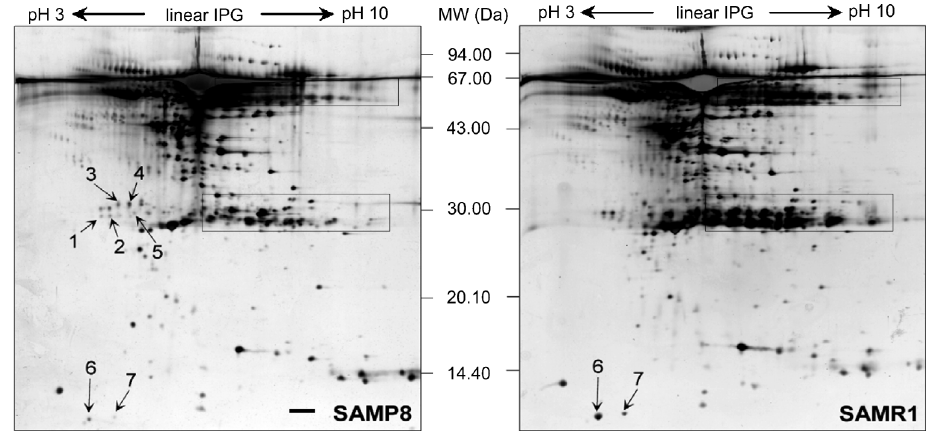
Figure 1. Representative 2-dimensional gels of serum proteins and differentially expressed protein spots. After determining the protein concentrationusing the Bradford assay, 150 m g serum proteinwas loaded on pH 3-10 linear IPG (Immobilized pH Gradient) strips(18 cm) for the first dimension electrophoresis and were then transferred to vertical 12.5% SDS-polyacrylamide gel for the second dimension electrophoresis. The gel was visualized by silver staining and analyzed by the ImageMaster Platinum TM software. The spots with different intensities when SAMP8 was compared to SAMR1 mice (12 months of age) were marked with arrows. The protein spots could not be further analyzed by mass spectrometry since they were not separated into single spots, as marked with rectangles. Bar = 1